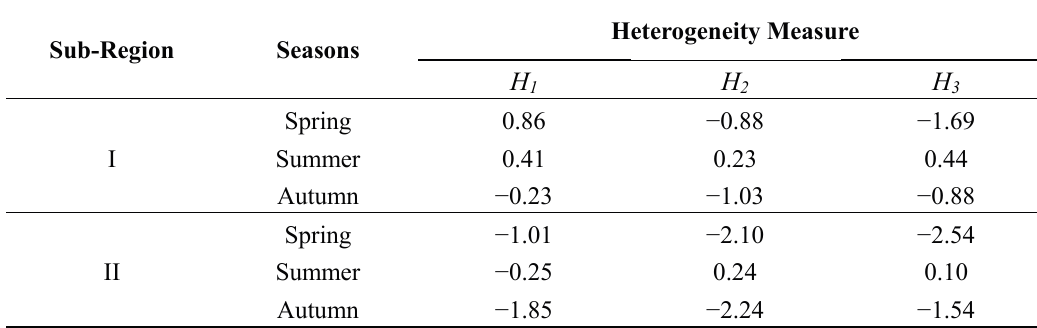
Table 5. Results of regional heterogeneity measure H .